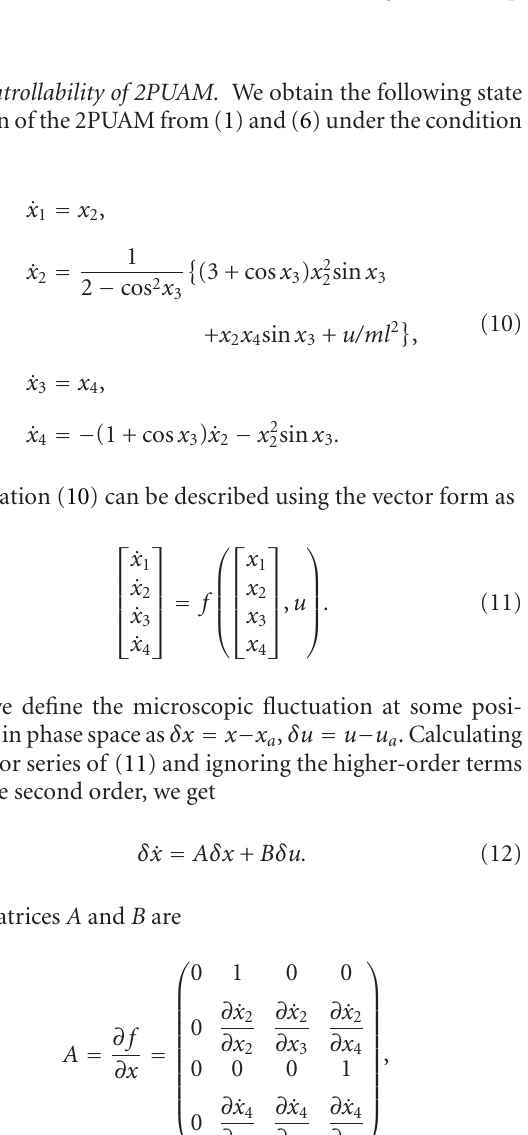
Figure 5: Schematic diagram of multiple predictor-controller pair architecture